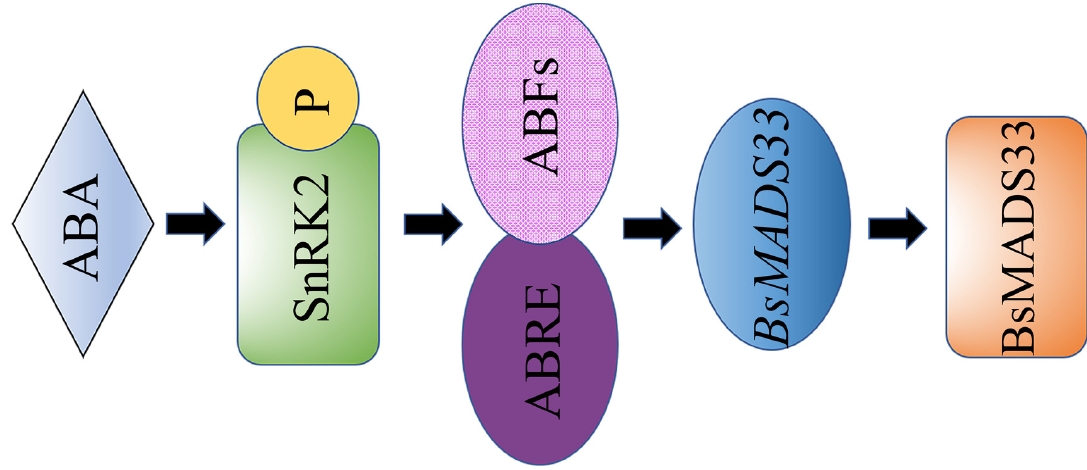
Figure 9. Annotation map of BsMADS33 hypothetical pathway in response to ABA stress .